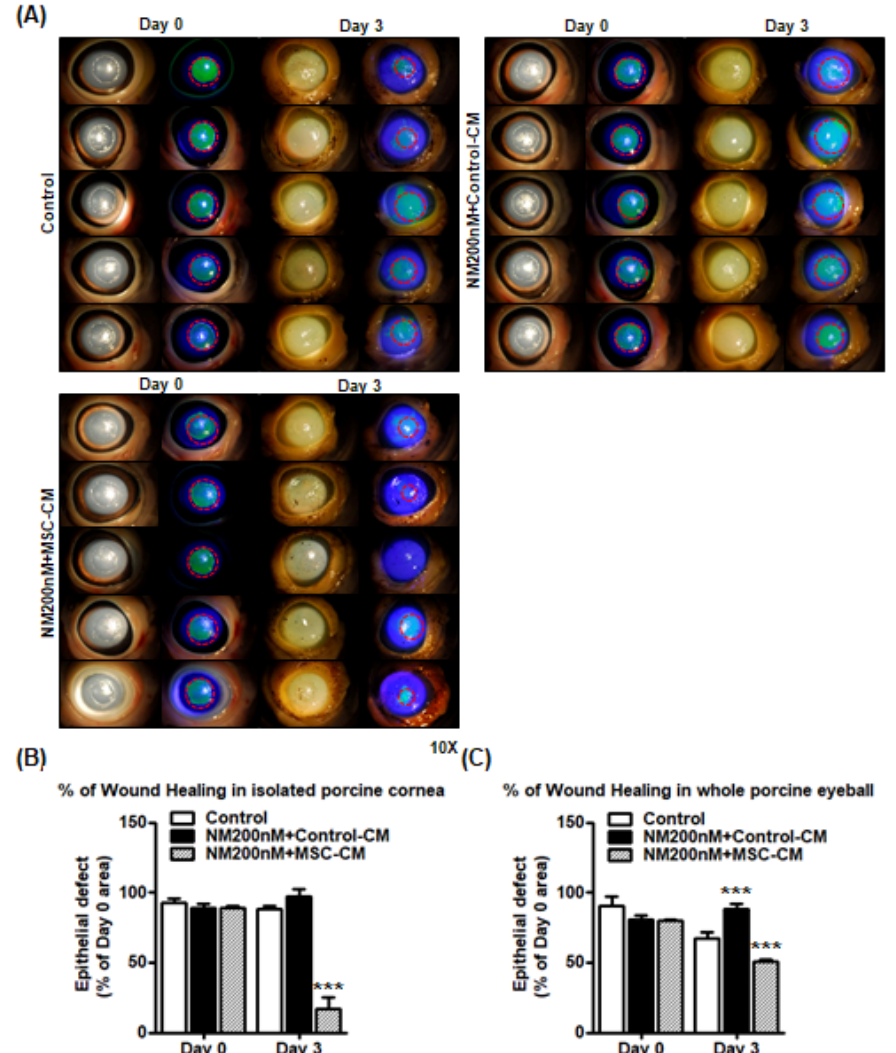
Figure 7. Wound healing effects of MSC-CM on NM injury in ex vivo porcine cornea culture model. ( A ) Ex vivo porcine cornea culture model for wound healing study: corneas were dissected from whole porcine eyes and a 6.5 mm wound was created on the porcine corneas. The 6.5 mm-wounded porcine corneas were cultured in various doses of NM 200 nM in KSFM media for 2 h and washed two times with 1X PBS. After washing, wounded porcine corneas were incubated with control (1:1 ratio of MEMa and 10% FBS/DMEM), NM 100 nM (in 1:1 ratio of time control media and 10% FBS/DMEM), and NM 200 nM (in 1:1 ratio of MSC-CM and 10% FBS/DMEM) for 3 days. A slit lamp was used to observe corneal staining (10× magnification) on Day 0 and Day 3. ( B ) Graph comparing epithelial defect area between groups (Control, NM 200 nM, and NM 200 nM + MSC-CM) at Day 0 to Day 3 (n = 5/group). *** p < 0.001 vs. NM200nM + Control CM (Day 3), ( C ) Graph comparing epithelial defect area between groups (Control, NM 200 nM, and NM 200 nM + MSC-CM) at Day 0 to Day 3 (n = 3/group) from Supplementary Figure S3. *** p < 0.001 vs. untreated control (Day 3). These